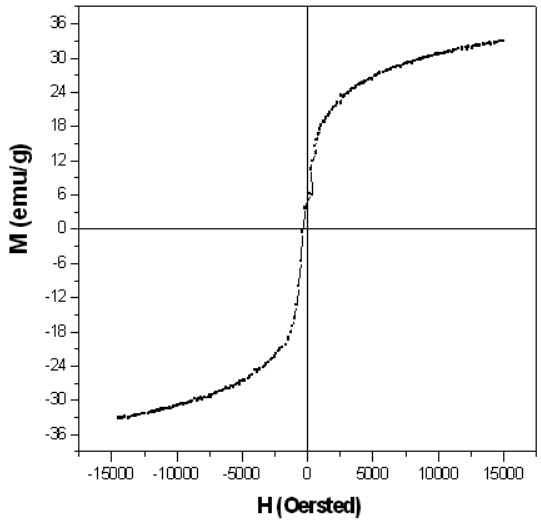
Fig. 5 – Magnetization curve of iron oxide magnetic particles.